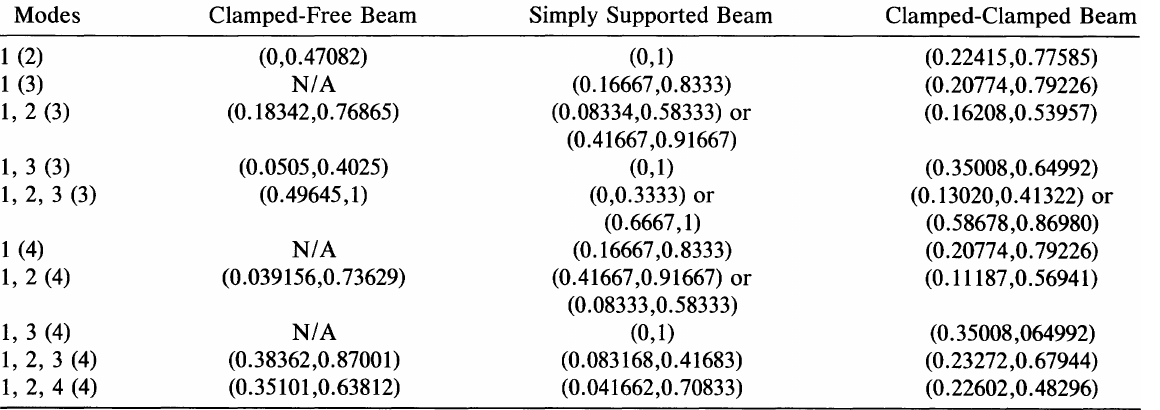
Table 1. Normalized Optimal Locations of a Piezoelectric Sensor Modes Clamped-Free Beam Simply Supported